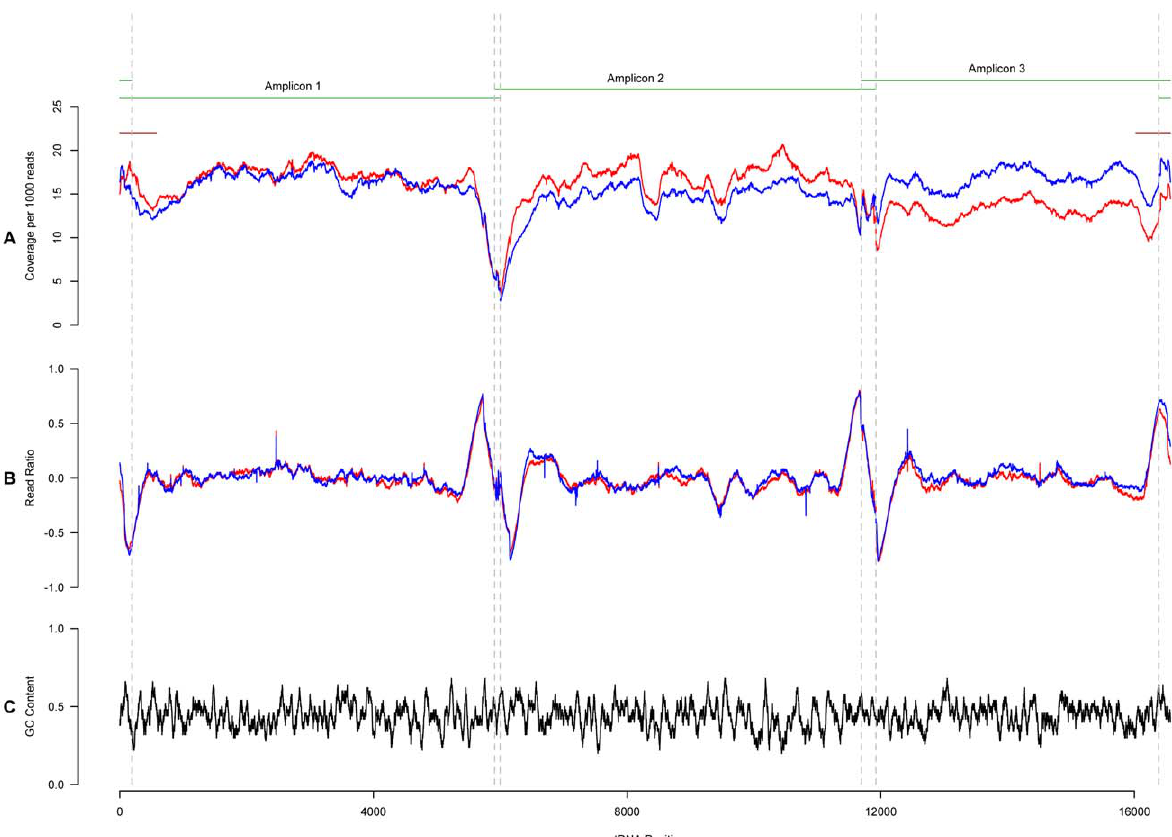
Figure 1. Coverage across the mitochondrial genome. The top portion of the figure shows where the three amplicons lie and overlap across the mtgenome. A) Coverage for all samples per population. For each sample the coverage at a particular position was normalized by dividing the total number of reads obtained for that sample by 1,000. B) The forward to reverse read ratio for the modal base was centered to 0 using the following statistic: [(forward/reverse) 2 1]/[(forward/reverse) + 1]. C) GC content across the mtgenome was calculated using a sliding window of 51 bp centered on the position in question.